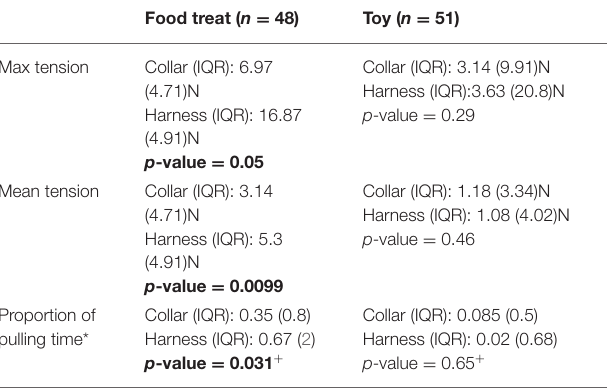
TABLE 2 | Bivariate analysis (Wilcoxon signed-rank test) of leash tension between neck collar and chest harness conditions.